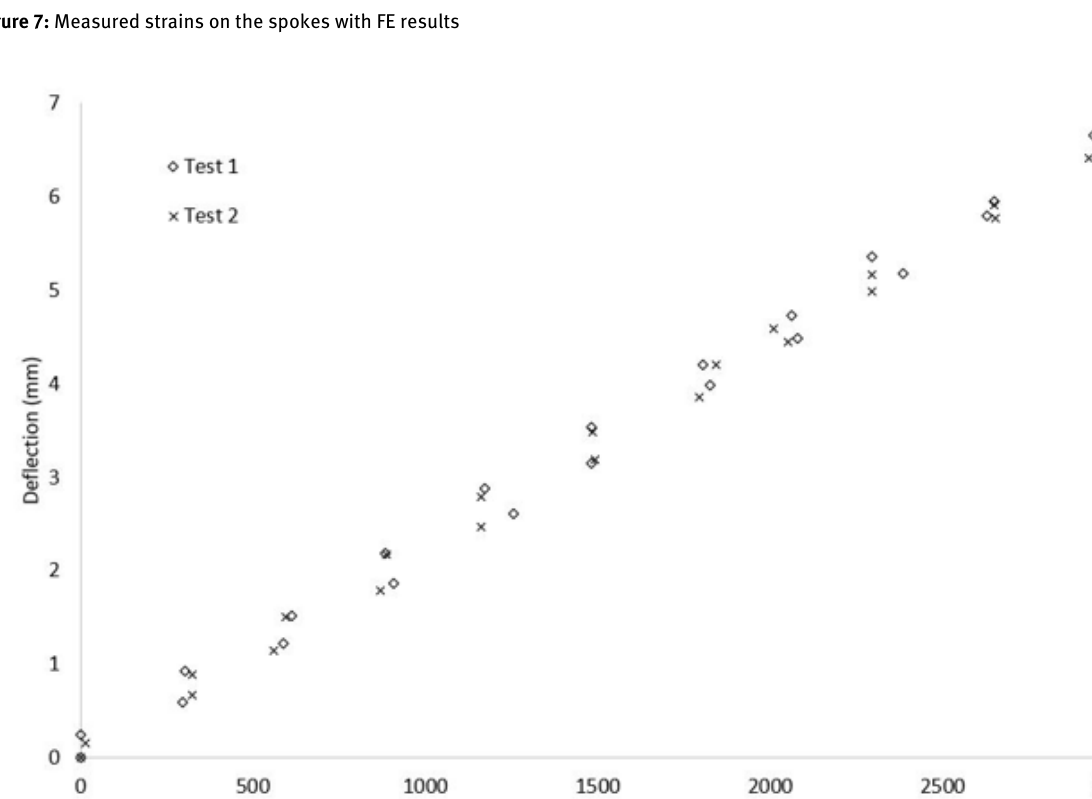
Figure 7: Measured strains on the spokes with FE results